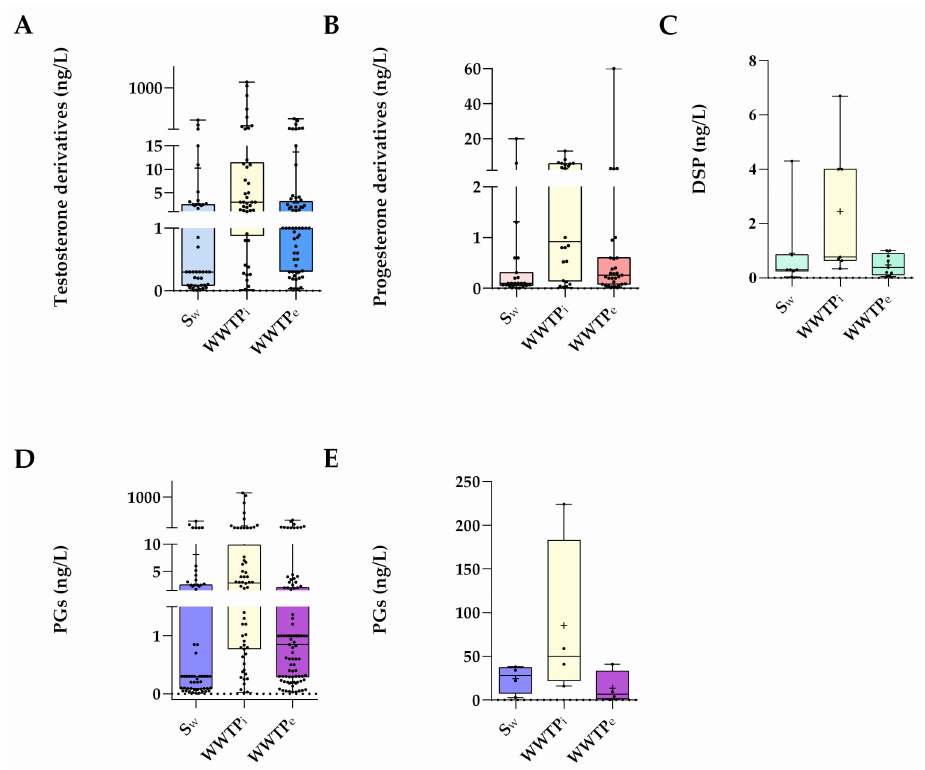
Figure 2. Data are expressed in boxplots with the minimum, median, maximum, average (+), and interquartile range Q1–Q3. Dots represent average individual values measured in surface waters (S w ), WWTP influent (WWTP i ) and WWTP effluents (WWTP e ) around the world concerning PGs derivates from ( A ) Testosterone (n = 42 S w , n = 42 WWTP i , and n = 62 WWTP e ), ( B ) Progesterone (n = 23 S w , n = 22 WWTP i , and n = 29 WWTP e ), ( C ) Spirolactone (n = 7 S w , n = 7 WWTP i , and n = 9 WWTP e ), ( D ) all PGs as a whole (n = 72 S w , n = 71 WWTP i and n = 100 WWTP e ), ( E ) all PGs referred in a previous review (n = 4) [7].